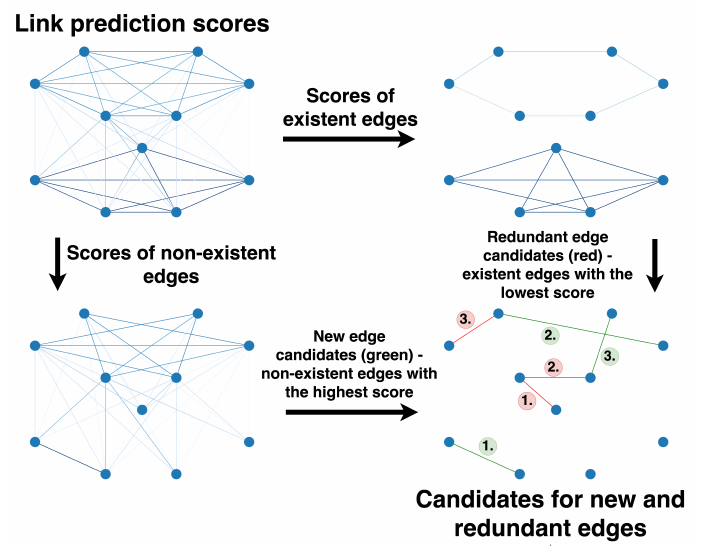
Figure 2. Overview of our methodology for finding missing and redundant